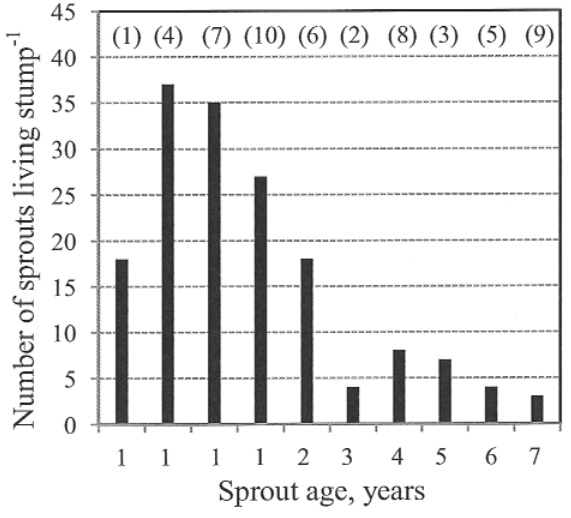
Figure 3. Number of sprouts per living stump as a function of sprout age. Location numbers are shown in